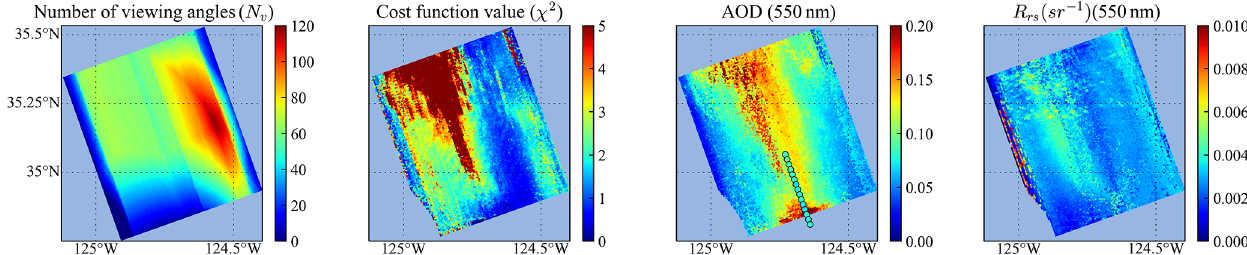
Figure 15. The number of viewing angles used in the retrieval ( N v ), the cost function value ( χ 2 ), the retrieved AOD (550nm), and R rs (550nm) for all pixels in Scene 1. The HSRL AODs at 532nm are indicated by the colored dots in the AOD plot.